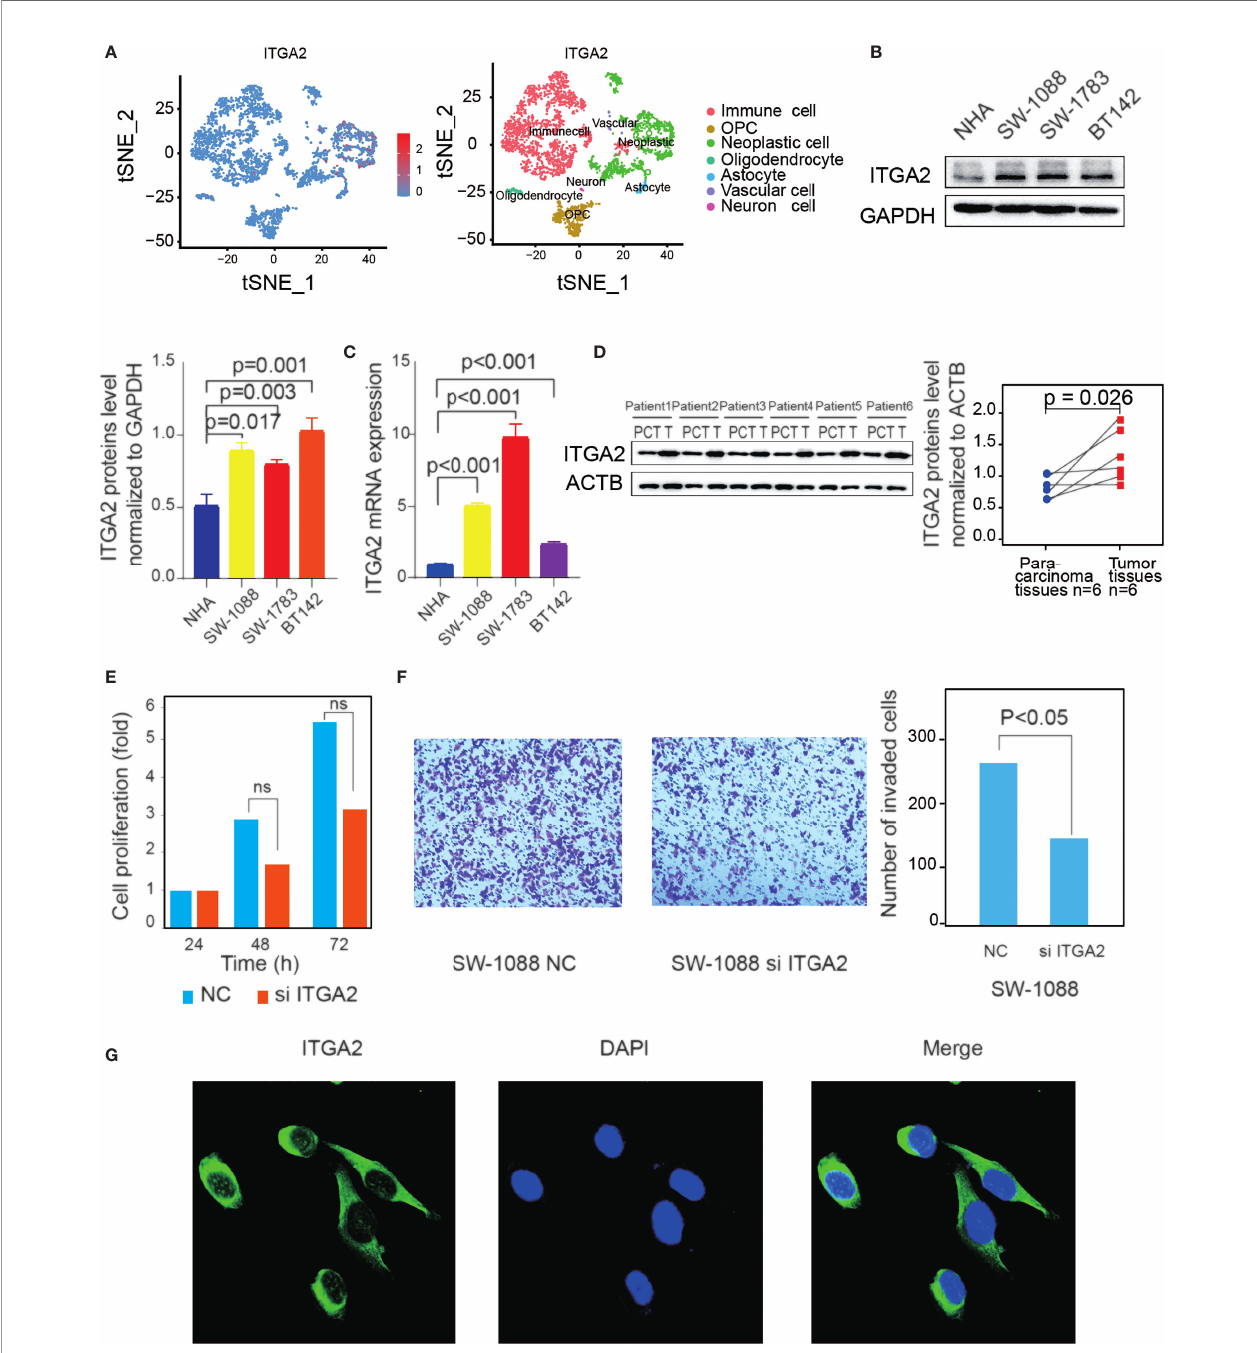
FIGURE 3 | Veri fi cation of the high expression of integrin alpha-2 (ITGA2) in lower-grade gliomas (LGGs) and immuno fl uorescence of ITGA2. (A) Expression abundance of ITGA2 gene in different color-labeled cell types. (B) Western blot (WB) and (C) quantitative real-time polymerase chain reaction analysis of ITGA2 expression in LGG cell lines and normal glial cells (NHA). WB was repeated in three independent experiments. (D) Western blot analysis of ITGA2 expression in six paired LGG tissues and the match para-carcinoma tissue of the same patient. The ITGA2 protein expression levels were quanti fi ed by ImageJ software. WB was repeated in three independent experiments. (E) The effect of ITGA2 knockdown on SW1088 cell proliferation. Paired t -test was used to analyze. [ns (nonsense)] (F) The trans-well assays of SW1088 cell line under the knockdown of the ITGA2. The quantitative analysis of the transwell invasion assays performed by Image J Paired t -test was used to analyze. (G) SW-1088 cells were treated with the rabbit anti-ITGA2 (green) at 4°C overnight, and nucleus stained by DAPI. The protein plots were cut by the original